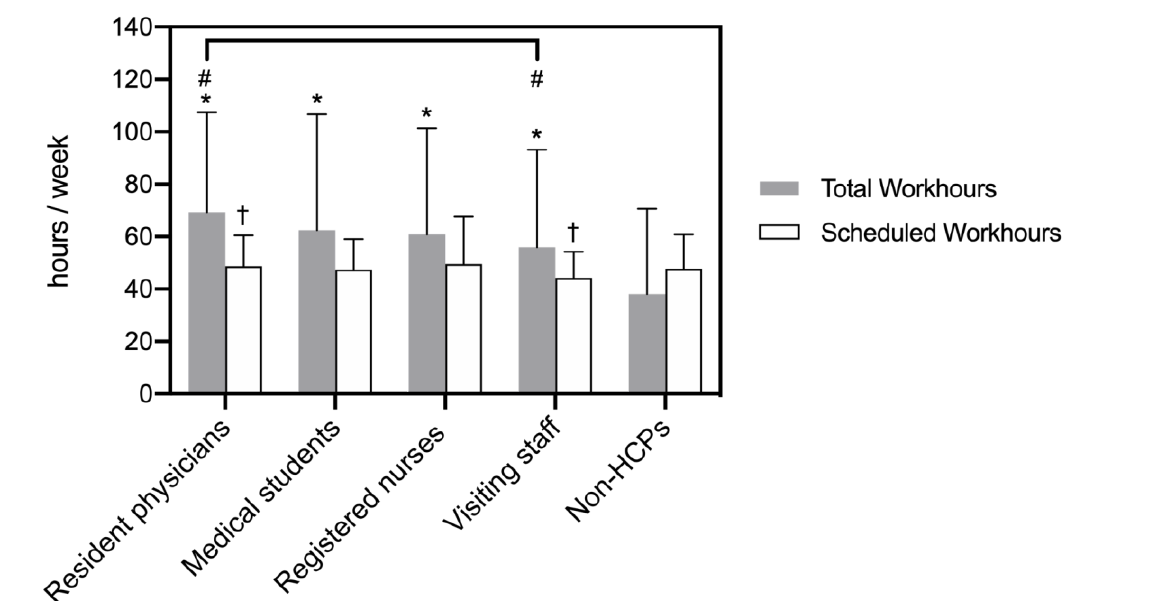
Figure 5. The bar graph compares the total work hours and scheduled work hours between five occupational categories. There were significant differences between the five categories of occupation ( p = 0.003). Post hoc comparisons further revealed that all medical staff had significantly longer total work hours (resident physicians: 69.40 ± 38.03, p < 0.001; medical students: 62.50 ± 44.18, p = 0.020; registered nurses: 60.83 ± 40.62, p = 0.040; visiting staff: 55.89 ± 37.25, p = 0.041) than non-healthcare professionals (38.12 ± 32.51), as indicated by the asterisks *. In addition, resident physicians had statistically significantly longer work hours than visiting staff, both in terms of total work hours (represented by #) and scheduled work hours (represented by †) .